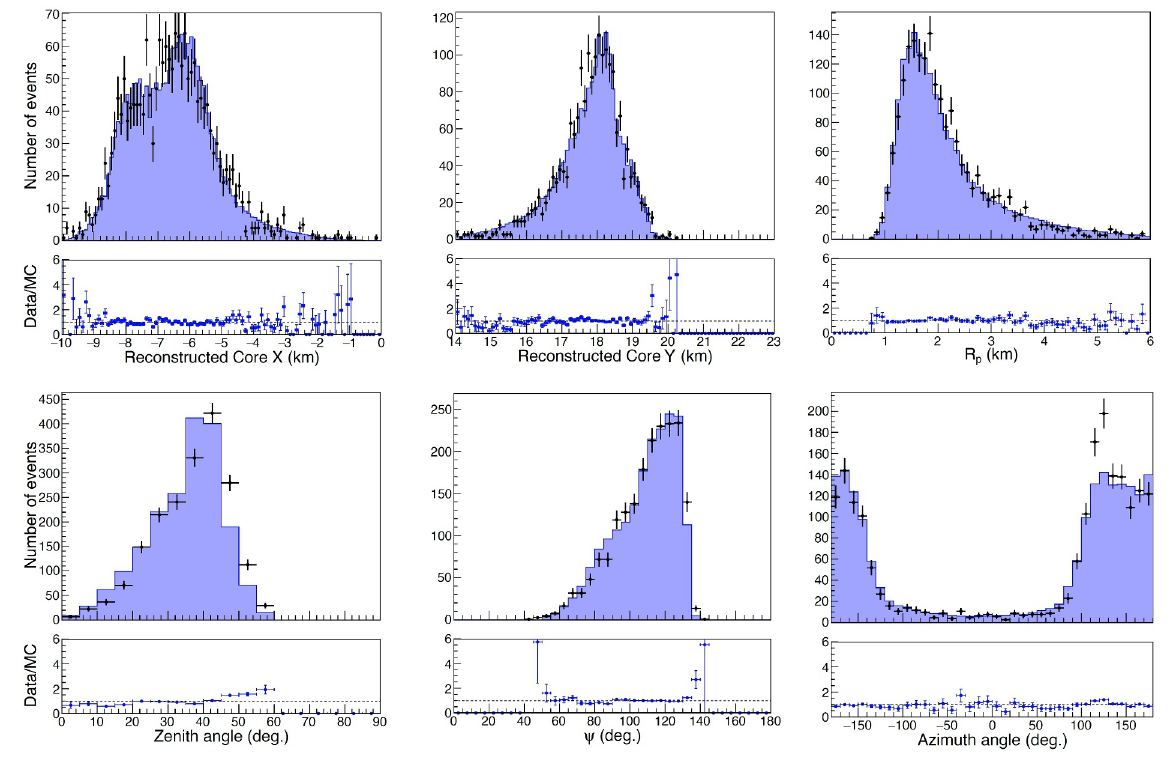
Figure 5. Distributions of reconstructed shower geometries. The data are shown by marker points and the MC prediction are shown by histogram. The MC predictions are normalized with the number of events in the data.